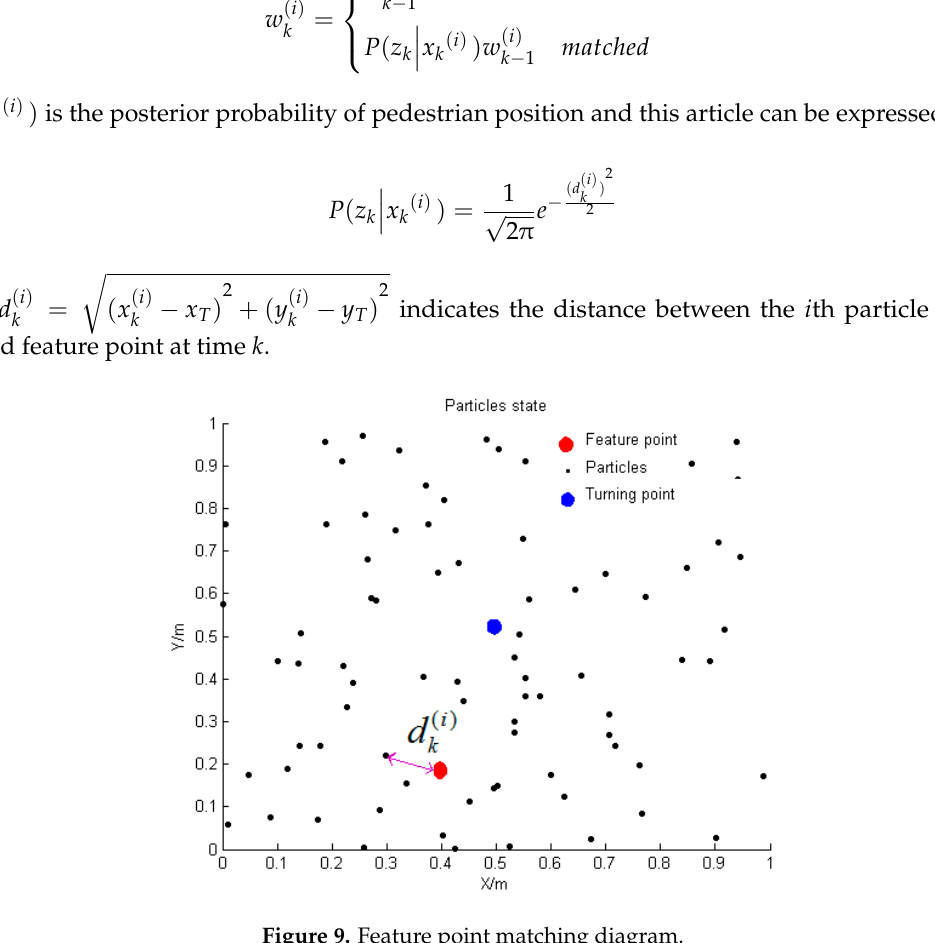
Figure 9. Feature point matching diagram.